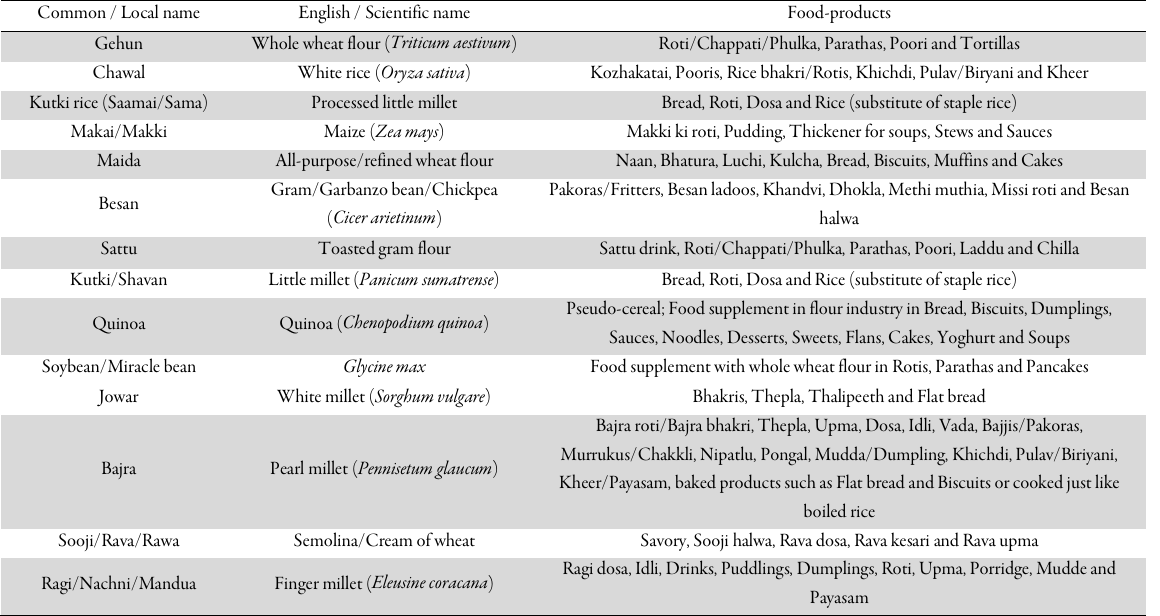
Table 1. List of commonly used staple Indian grain flour types Common / Local